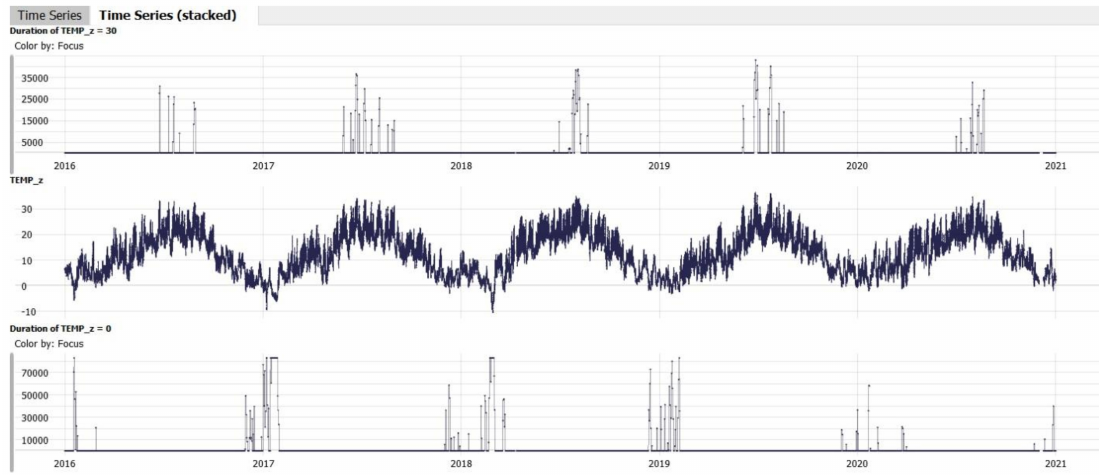
Figure 8. Annual distribution and diurnal duration (expressed in seconds) of temperature breaching a predefined threshold for Zürich: temperature maxima ( above ), temperature minima ( below